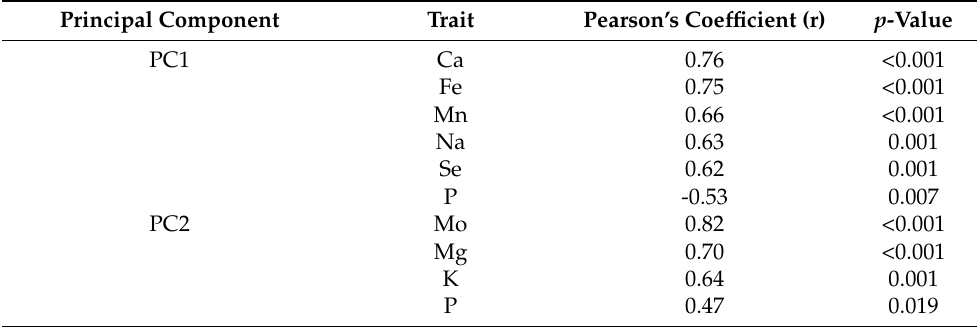
Table 7. Correlation coefficients between the principal components, PC1 and PC2, and macro-ele- ments (Na, Mg, P, K, Ca) contents and micro-elements (Fe, Zn, Mn, Cu, Se, Mo, Ni) contents. Only significant correlations are shown ( p < 0.05).